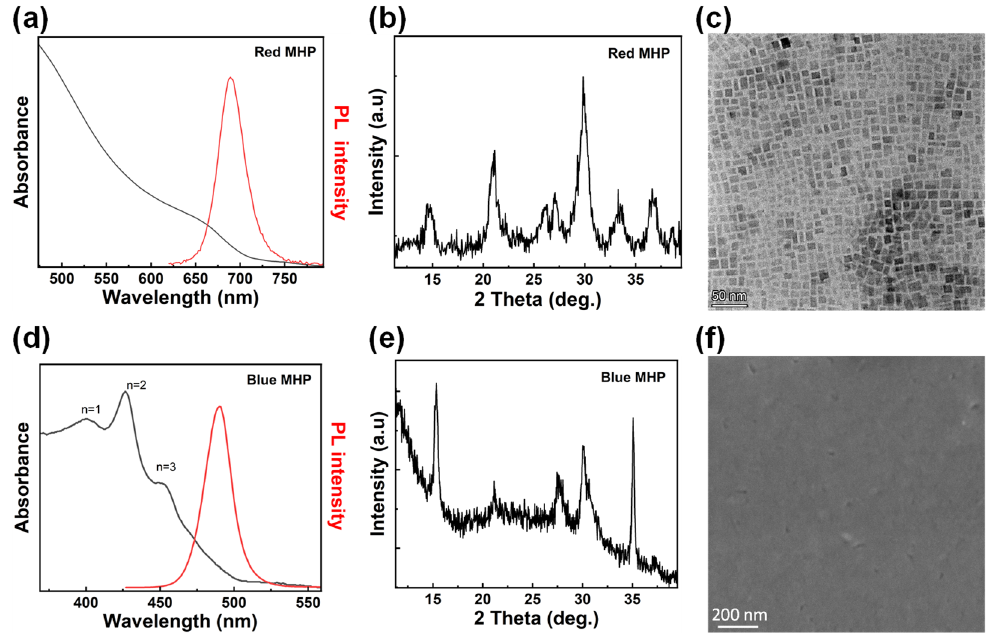
Figure 1. ( a ) PL and absorbance spectra of Zn-CsPbI 3 nanocrystal film. ( b ) XRD spectrum of Zn-CsPbI 3 nanocrystal film. ( c ) TEM image of Zn-CsPbI 3 nanocrystals. ( d ) PL and absorbance spectra of PEA 2 (Cs 1-x EA x PbBr 3 ) 2 PbBr 4 film. ( e ) XRD spectrum of PEA 2 (Cs 1-x EA x PbBr 3 ) 2 PbBr 4 film. ( f ) SEM image of PEA 2 (Cs 1-x EA x PbBr 3 ) 2 PbBr 4 film.